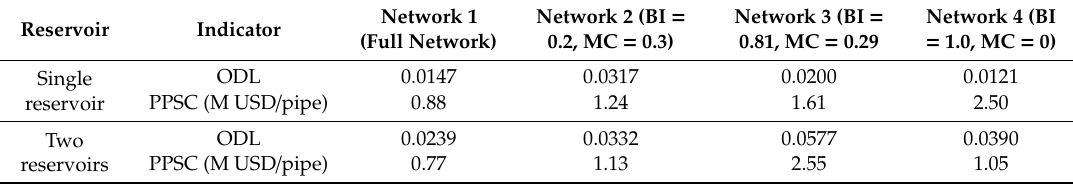
Table 4. ODL and PPSC obtained under the single- and two-reservoir supply conditions. Reservoir